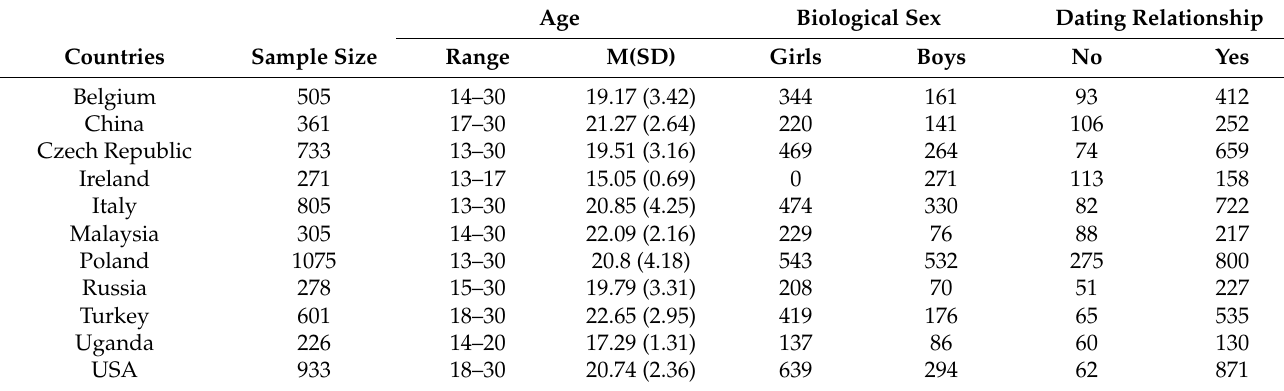
Table 1. Sample characteristics by